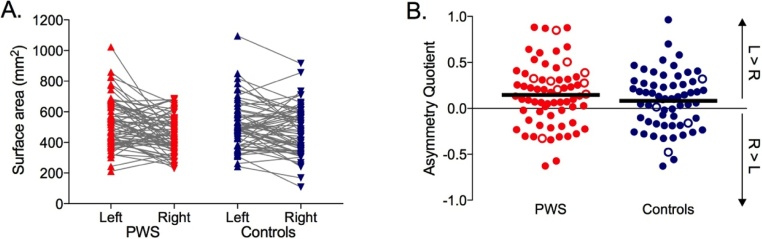
Surface area measurements of the PT. (A). Left and right hemisphere measurements shown for individual PWS and Controls. (B). Asymmetry Quotients for individual participants. Red symbols – PWS, blue symbols – Controls, filled circles – right handers, open circles – left handers, solid black lines – group means, L – left, R – right. (For interpretation of the references to colour in this figure legend, the reader is referred to the web version of this article.)